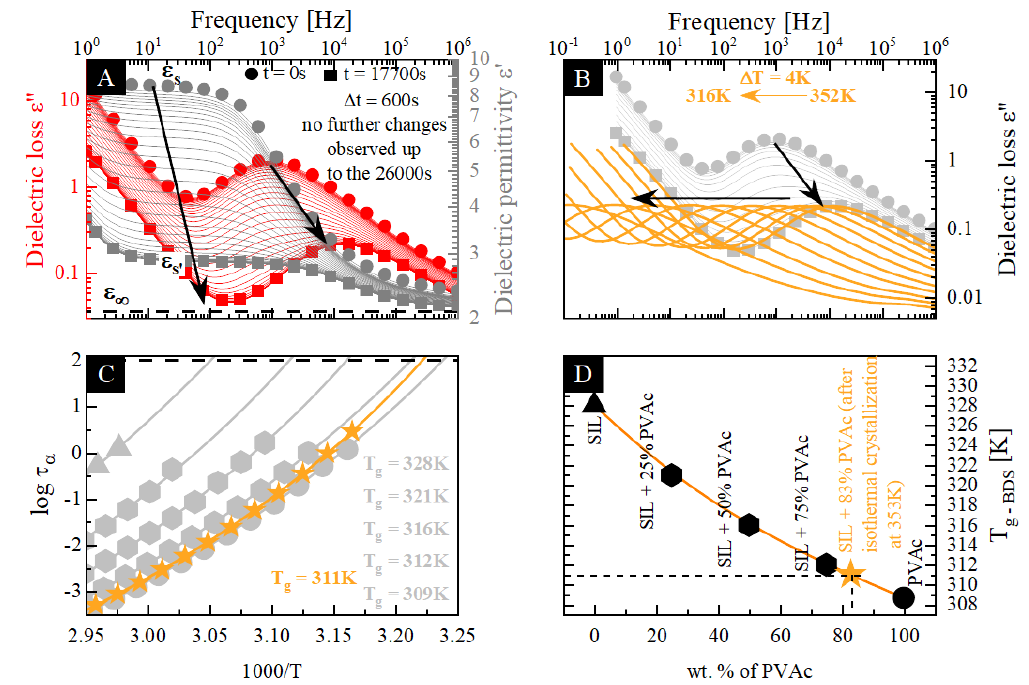
Figure 8. ( A ) presents dielectric spectra obtained during isothermal measurements (at 353 K) performed on the fully amorphous sample (SIL + 25% PVAc). ( B ) presents additional measurements performed on the partially amorphous sample, after its recrystallization at 353 K. Grey lines correspond to the isothermal crystallization while the orange lines correspond to the non-isothermal measurements performed during cooling from the temperature of performed isothermal measurement to 316 K. ( C ) shows the temperature dependence of the relaxation times of the fully amorphous samples (grey triangles), as well as the samples after isothermal crystallization (orange stars). Temperature dependence of τ α in the supercooled liquid was described by the VFT equations (grey and orange solid lines). ( D ) shows a concentration dependence of the glass transition temperatures of the SIL-based ASD systems, determined by BDS. Grey triangle, circle and hexagons are assigned to the neat amorphous SIL, PVAc and its binary mixtures. Orange star refers to the concentrations determined via isothermal measurements performed at 353